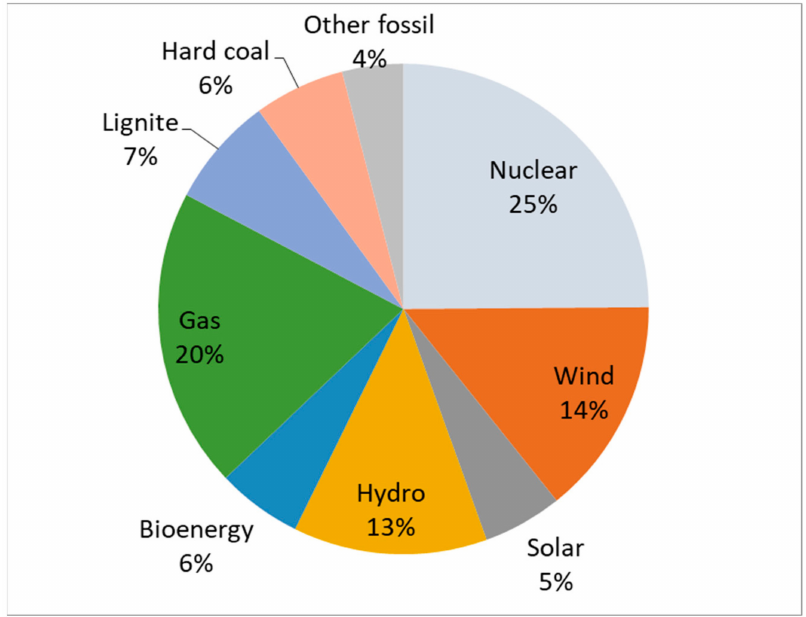
Figure 1. Electricity generation by fuel in the European Union in 2020 [1]. The sum of renewables (wind, solar and hydro) exceeds the contribution of nuclear, which, however, represents the single major low-carbon electricity